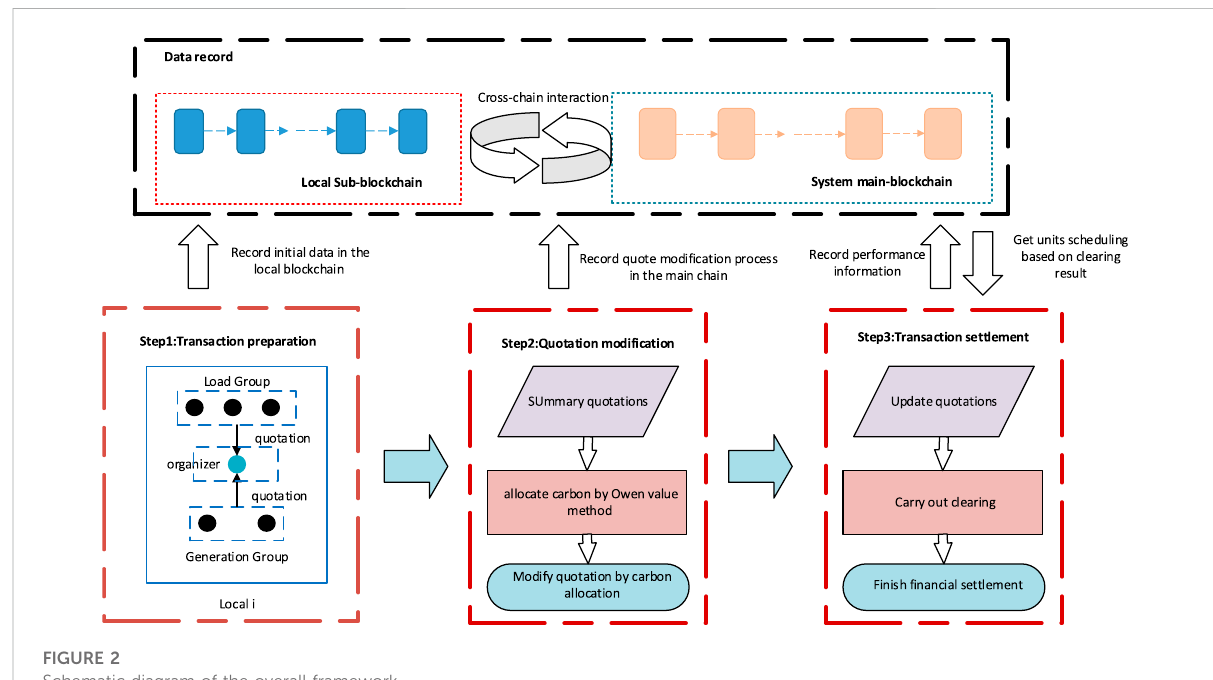
FIGURE 2 Schematic diagram of the overall